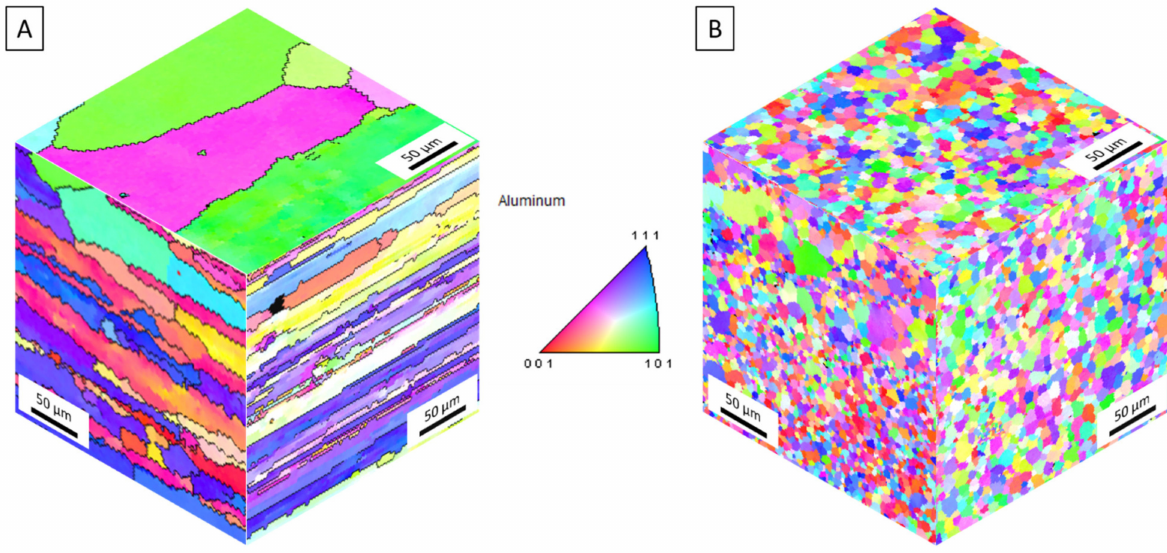
Figure 4. EBSD maps in 3-orientations of ( A ) the rolled AA5083-H131 feedstock and ( B ) as-deposited AA5083. Scale bars are 50 µ